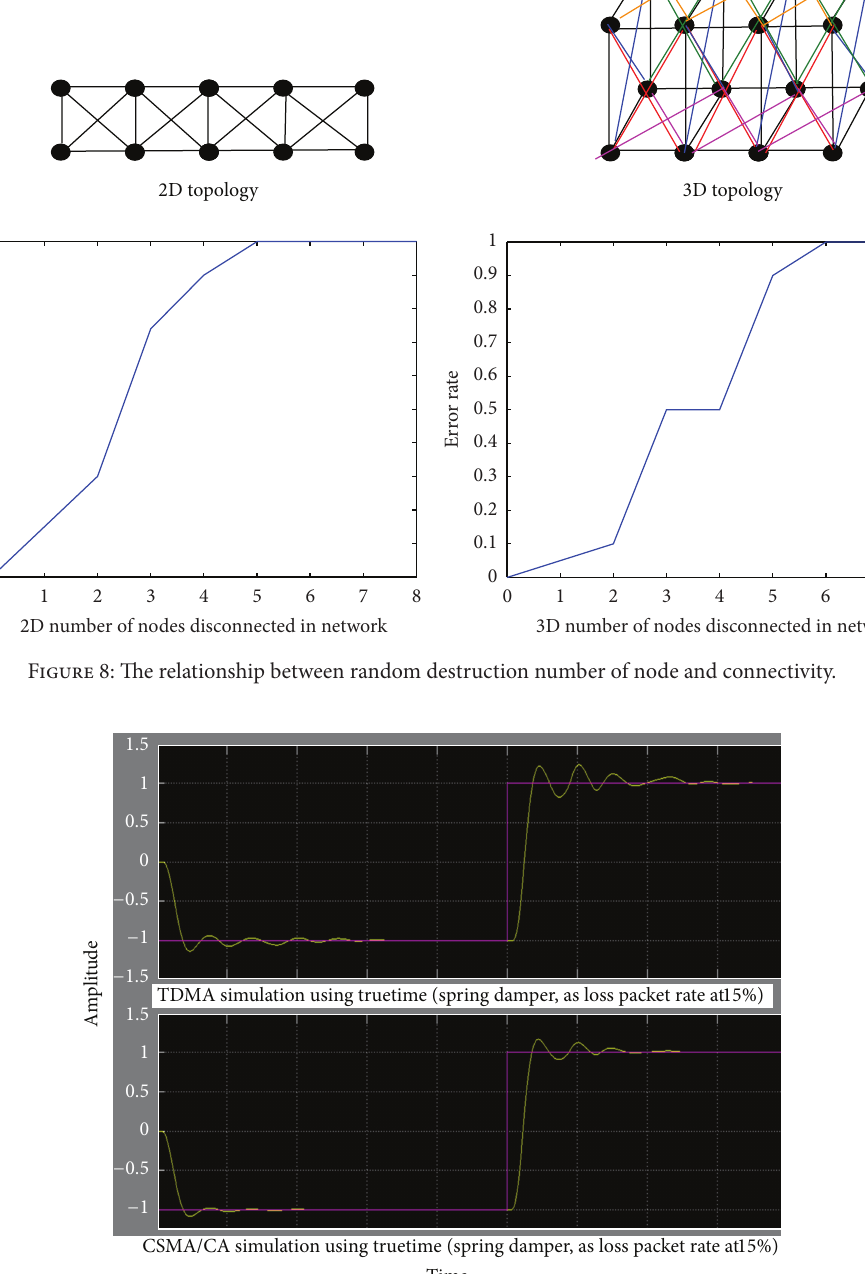
form another different subgraphs and outlier of algebraic